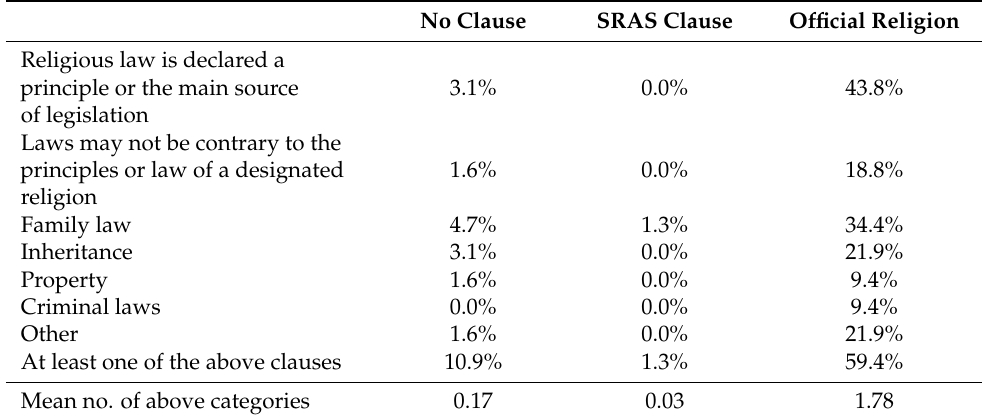
Table 6. Types of laws that are subject to religious law or associated with religion in